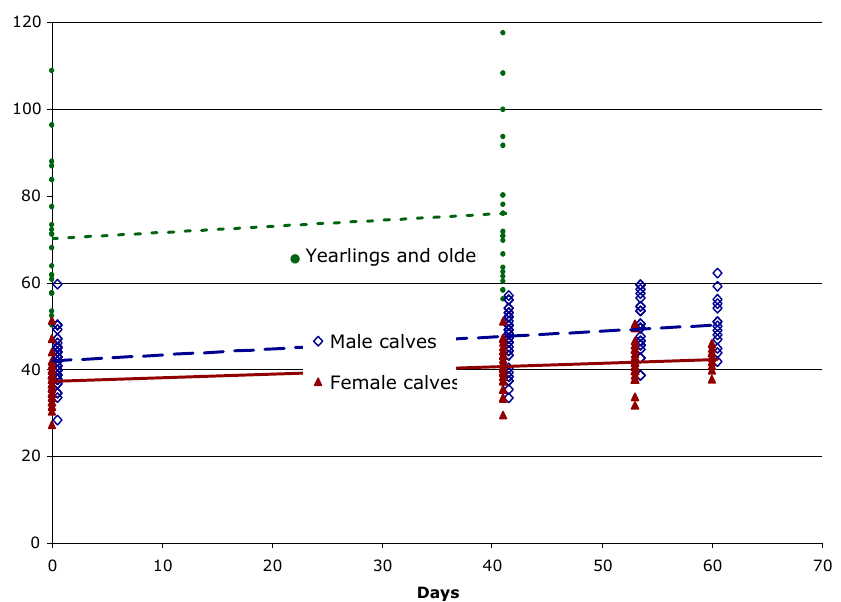
Fig. 1. Live body mass change for the different categories of reindeer during the experiment (body mass is recalculated according to the average relative carcass weight at each weighing occasion, respectively, to compensate for possible systematic differences in the amount of stomach